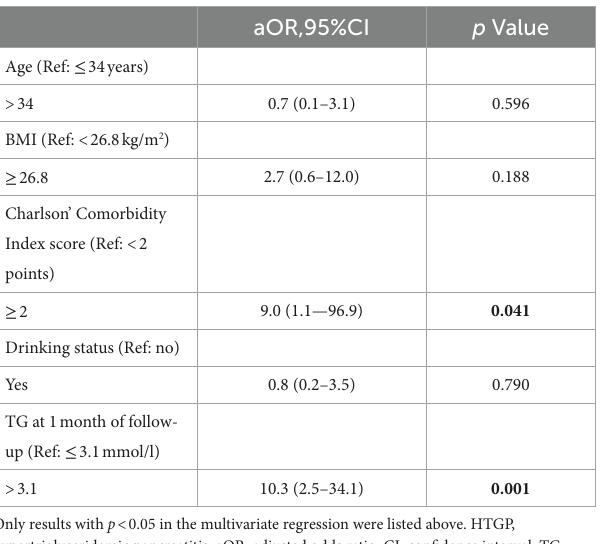
TABLE 5 Multivariate logistic regression analysis for recurrence in patients with HTGP.